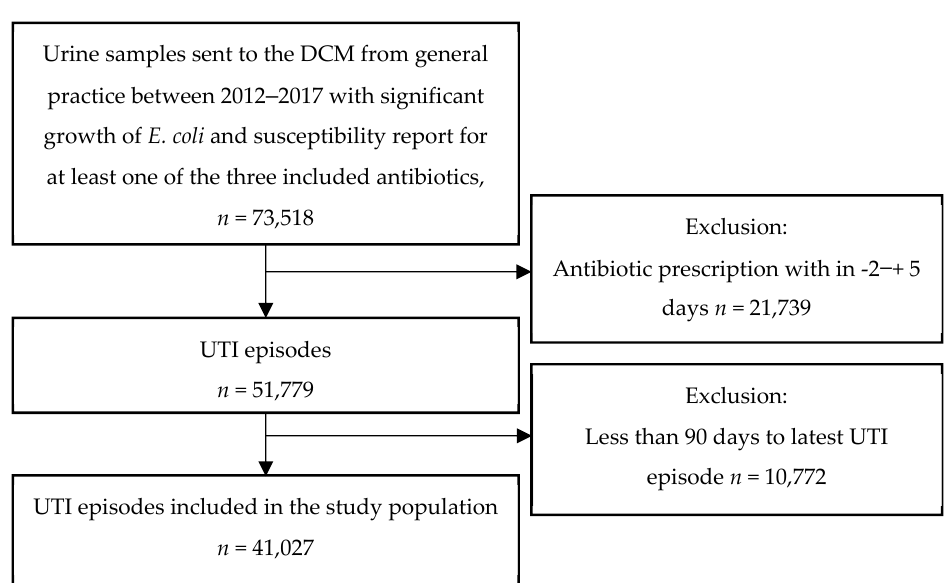
Figure 2. The inclusion of urine samples in the study.